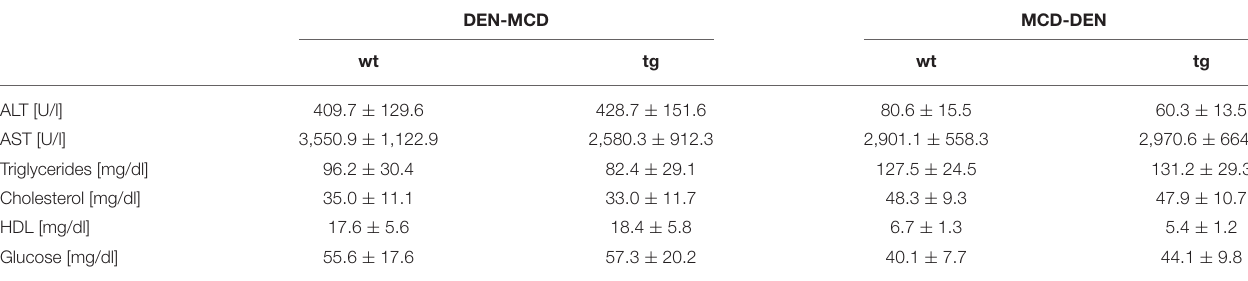
TABLE 3 | Serum parameters in DEN-MCD and MCD-DEN treated